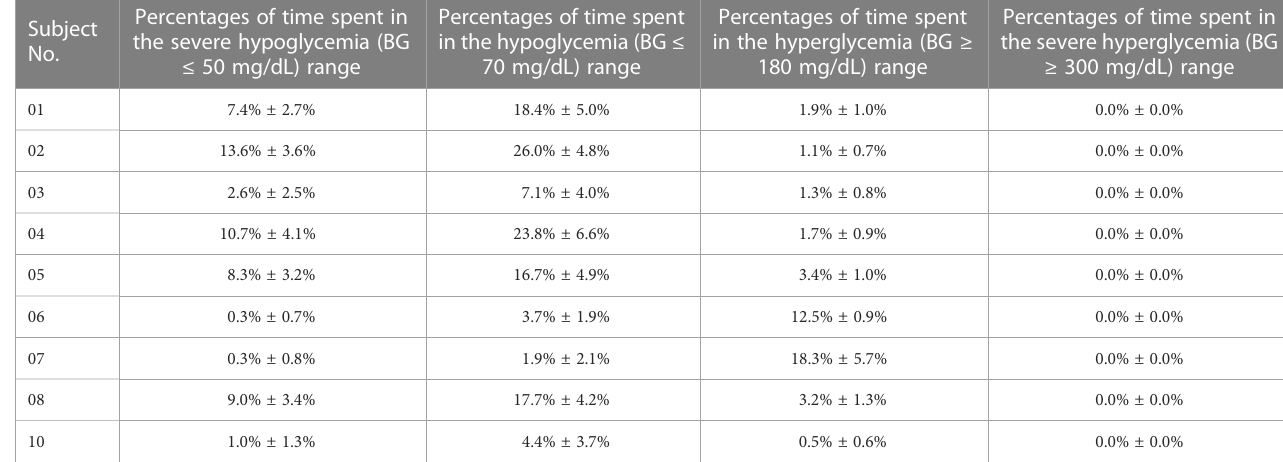
TABLE 2 Percentages of time spent in the severe hypoglycemia (BG ≤ 50 mg/dL) range, the hypoglycemia (BG ≤ 70 mg/dL) range, the hyperglycemia range (BG > 180 mg/dL), and the severe hyperglycemia range (BG > 300 mg/dL) of each in-silico subject with the GPC+IOB controller.